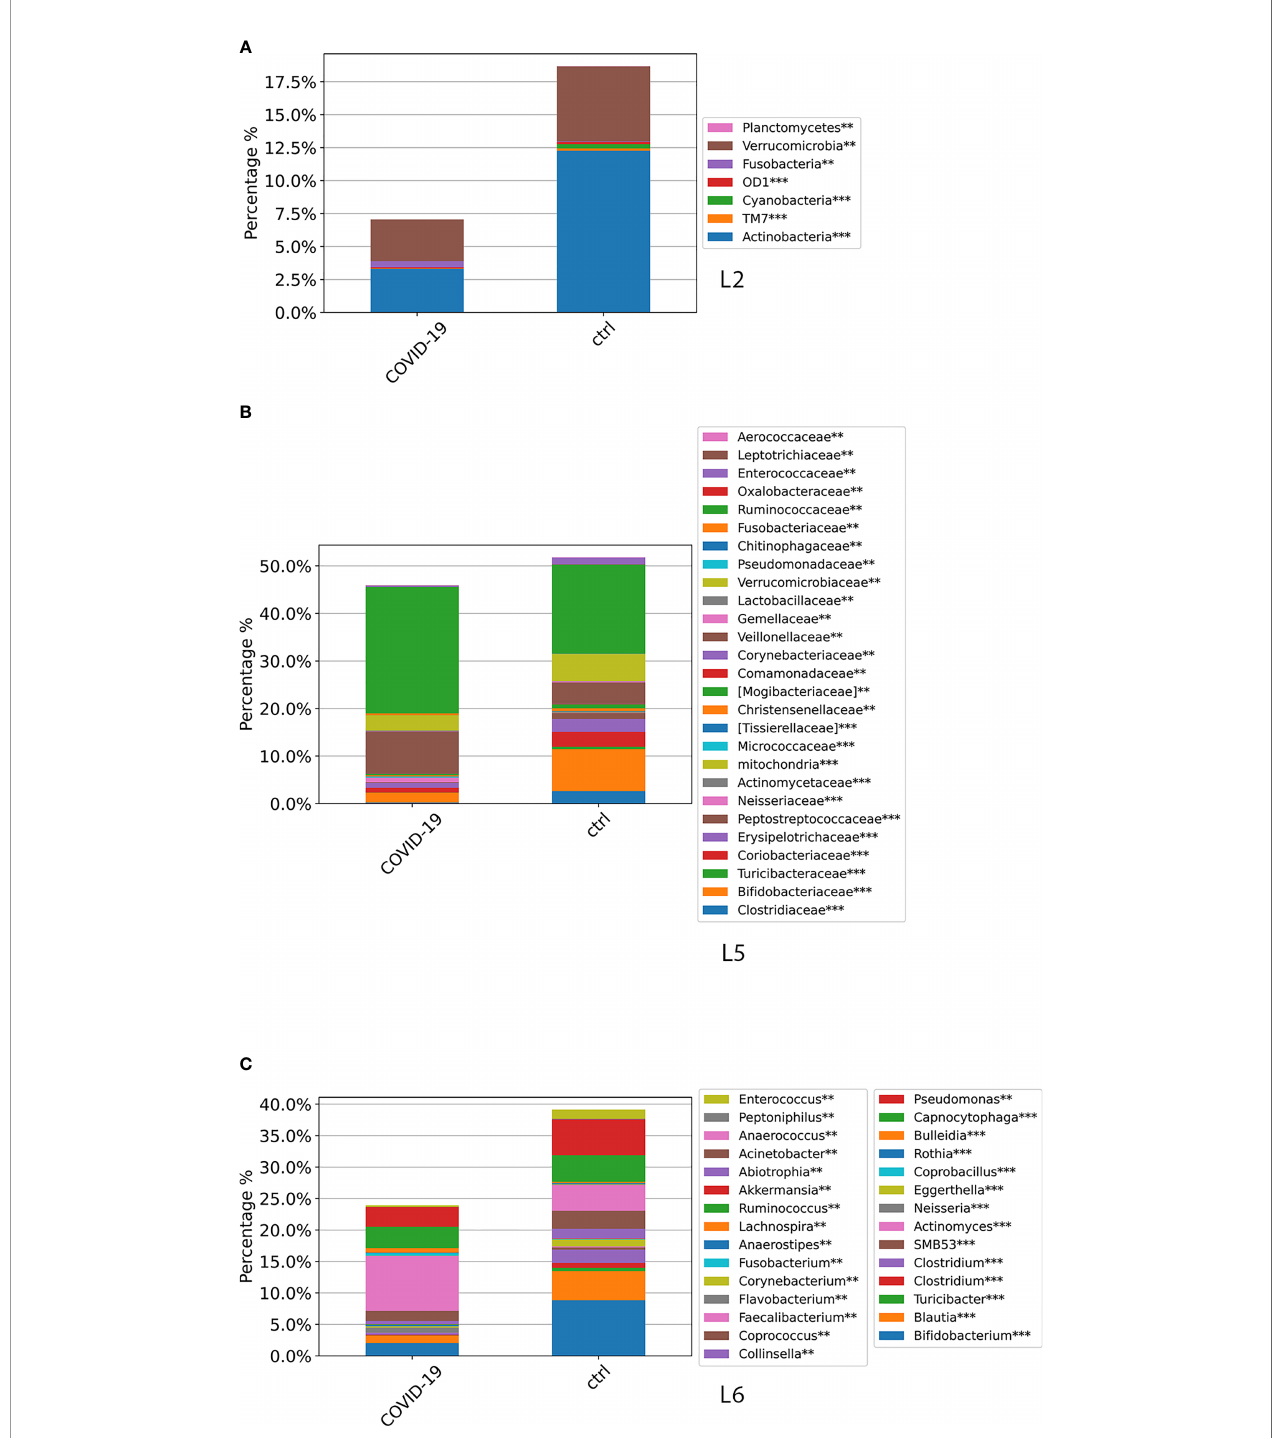
FIGURE 5 | ASV distributions at L2 (A) , L5 (B) , and L6 (C) fi ltered by statistically signi fi cance based on the Kruskal – Wallis test. * p -value < 0.001; p -value **FDR < 0.05; *** p -value FDR < 0.001. ASV distributions were reported in the comparisons among COVID-19 and CTRL subjects at the admission